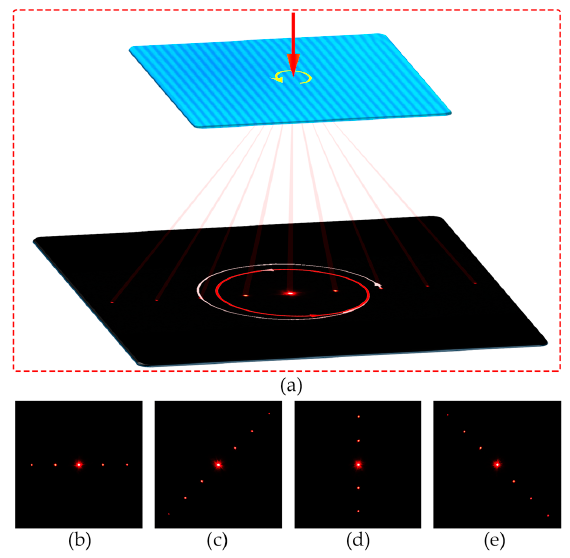
Figure 5. ( a ) Schematic diagram of the optical path for the beam steering characterization. ( b – e ) Diffraction patterns collected in the directions of 0°, 45°, 90°, and 135°, respectively.